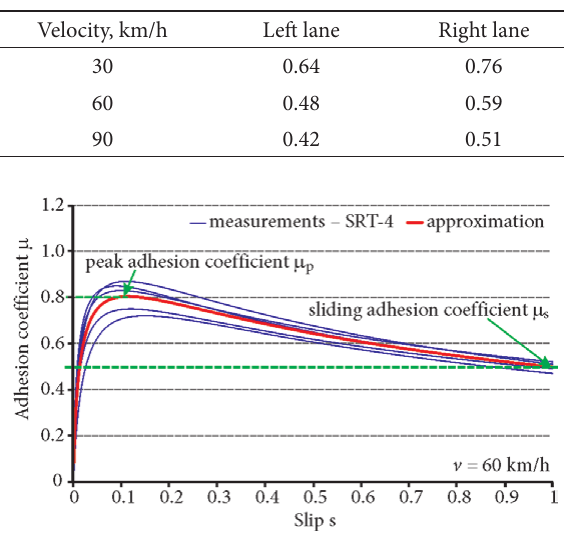
fig. 4. Adhesion characteristics μ(s) of one road section: blue – curves obtained for separate points; red – average characteristic